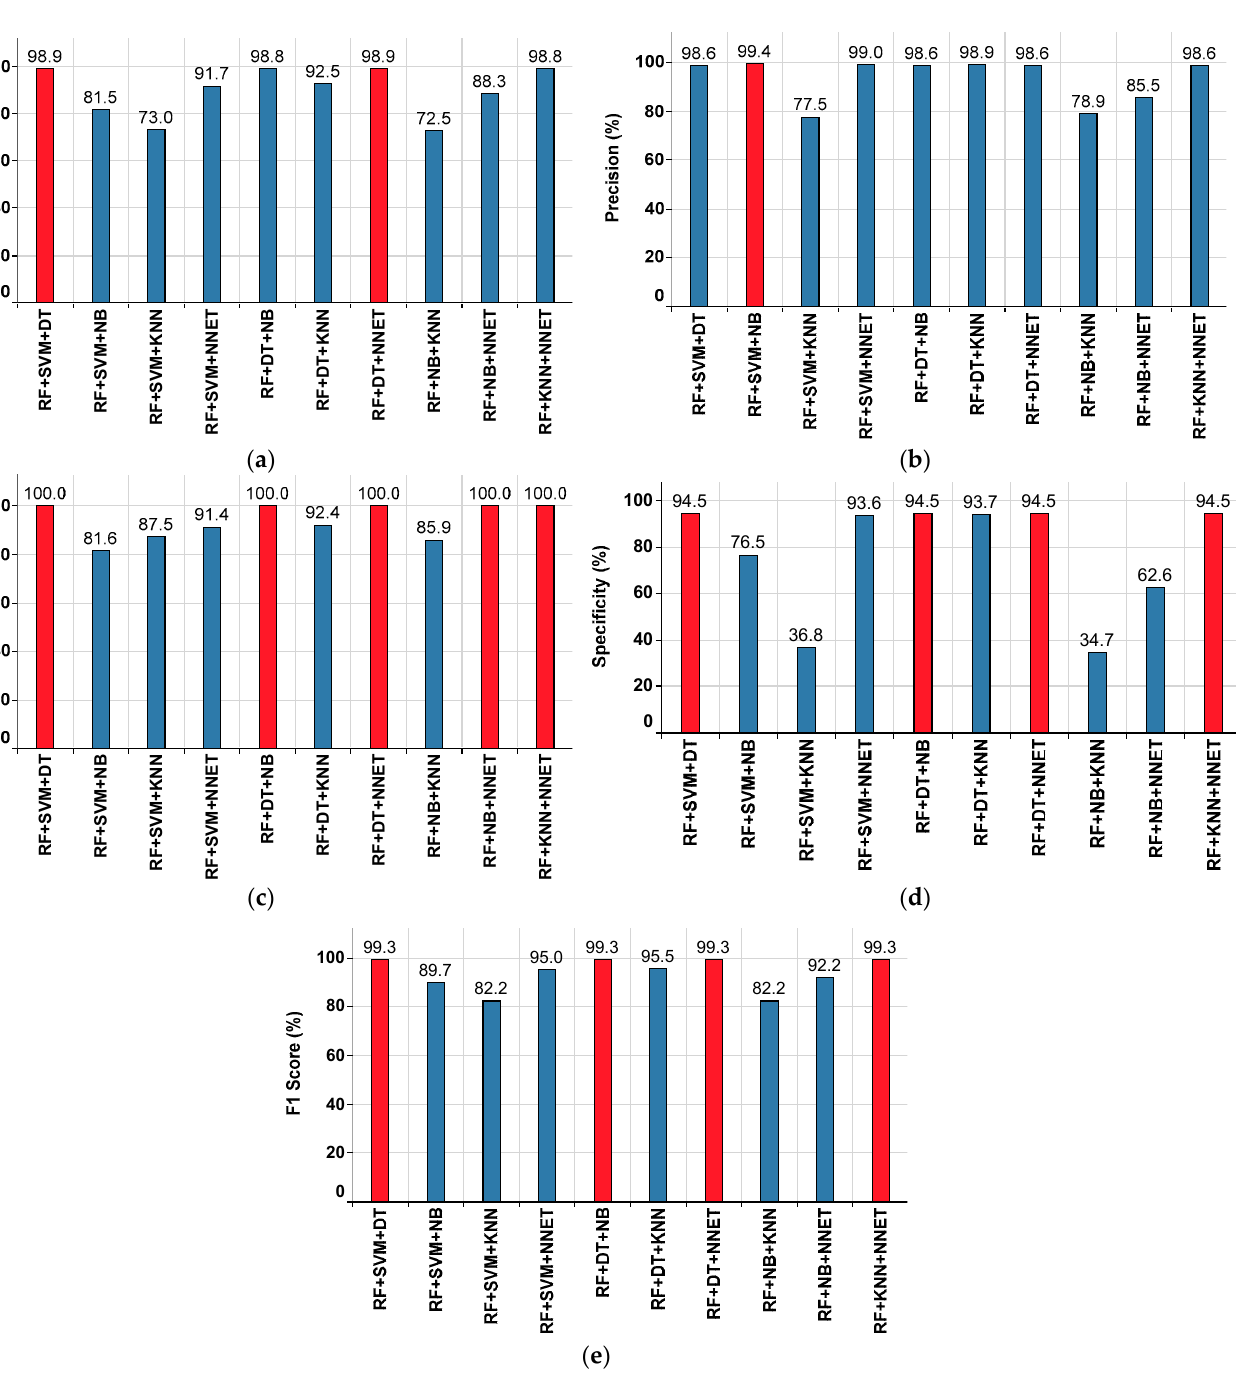
Table 4. Performance comparison of the ensemble classifiers approach on the median imputed da- taset.